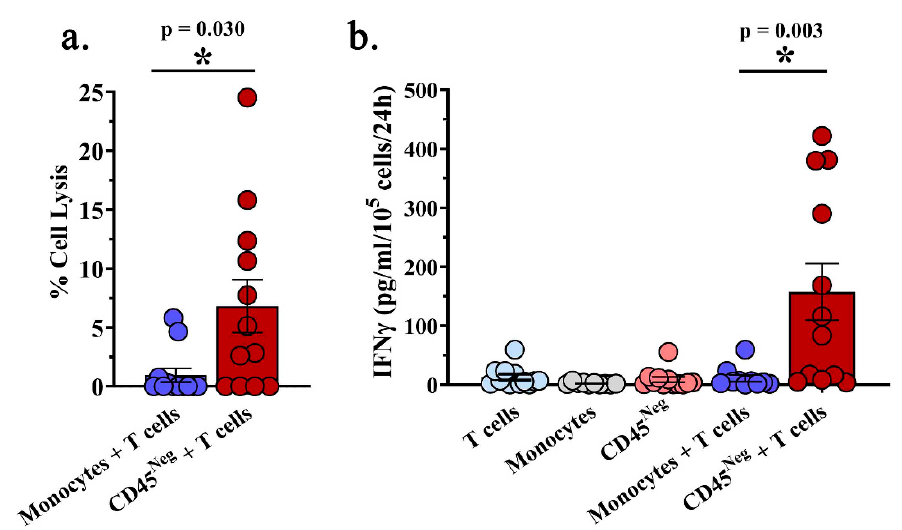
Figure 2. CD8 + T cells from MPEs possess functional activity following short-term culture in IL-2. CD8 +